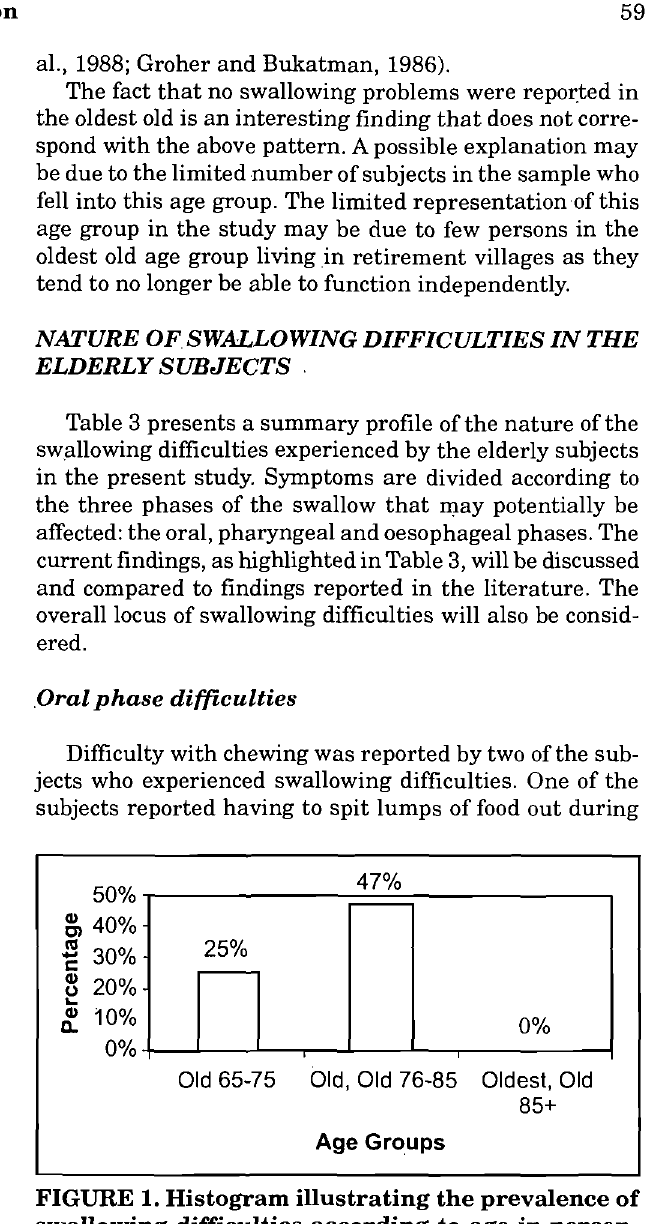
FIGURE 1. Histogram illustrating the prevalence of swallowing difficulties according to age in percen tage.